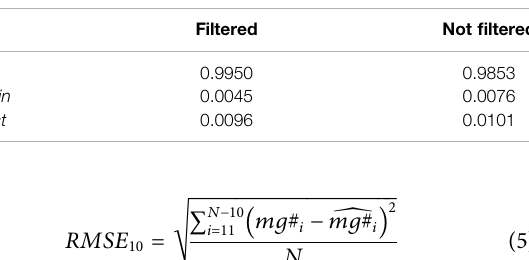
TABLE 4 | Performance statistics of the fi ltered and not fi ltered